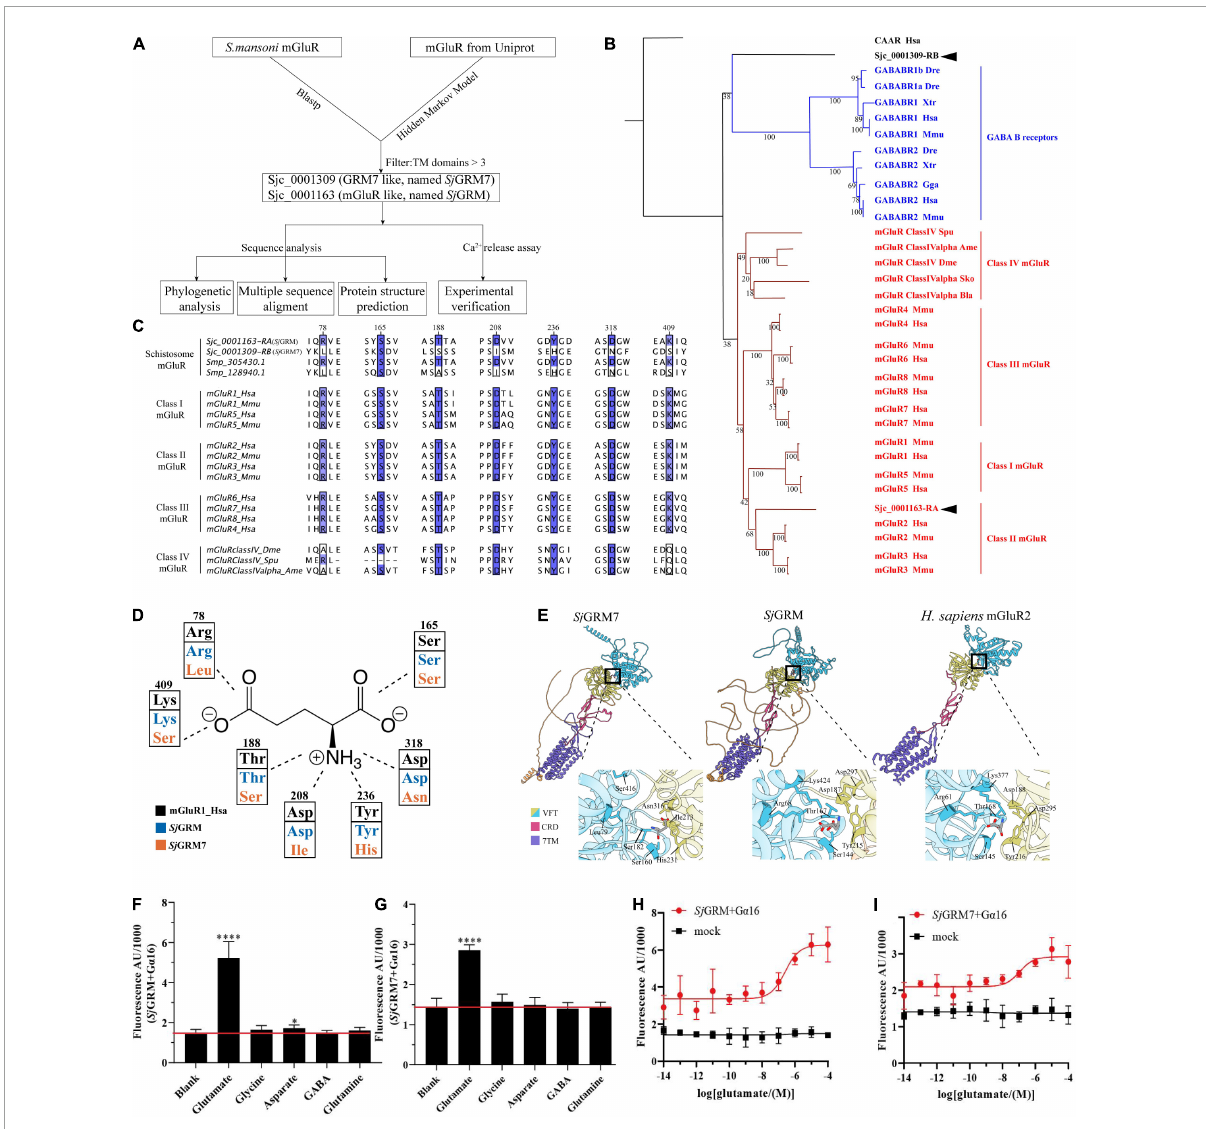
FIGURE1 Bioinformatic analysis reveals Sj GRM7 as a schistosome-specific mGluR. (A) A schematic for bioinformatics and functional analysis of S. japonicum mGluR. (B) mGluR maximum-likelihood tree. mGluRs and GABAB receptors (GABABR) are indicated by the branches and text colors. The text on the right shows further classification. Two S. japonicum mGluRs are highlighted in black. The species used in this analysis are implicated using a three-letter species code, except for S. japonicum (Sjc), S. mansoni (Smp), and Schmidtea mediterranea (SMESG). Phylogenetic reconstruction was performed using the maximum-likelihood method with the WAG + I + G + F model and an ultrafast bootstrap of 1,000 iterations. Bootstrap values are shown at the tree nodes, and protein names are shown at the end of each branch. The human calcium-sensing receptor was used as an outgroup. The scale bar denotes the number of amino acid substitutions per site. (C) Multiple protein alignments of mGluR ligand-binding residues. Representative sequences were chosen for each class with labels on the left. Key residues are colored according to percentage identity. The residue numbers indicated at the top correspond to those in human mGluR1. (D) Schematic depiction of mGluR’s key residues involved in ligand binding. Human mGluR key residues and those of S. japonicum are shown for comparison. As shown in panel (C) , the residue and its number corresponded to multiple protein alignments. Residues are colored based on proteins, as shown in the legend. The dashed line indicates the part of the glutamate the residue that interacts with other residues. (E) Protein structure comparisons between the predicted two mGluRs of S. japonicum structures and human mGluRII crystal structures. Different classes corresponded to other protein domains, as shown in the legend. Orange structures are intra-cellular regions, but most have low confidence (pLDDT < 50). Dashed lines in human mGluR2 denote disordered fragments. The binding pockets are shown by black boxes and are zoomed at the bottom right of each structure. Key residues involved in ligand binding are depicted in close-up views using the residue number and three-letter code. (F) Sj GRM-expressing HEK293 cells were treated with various amino acid transmitters ( L -glutamate, glutamine, GABA, glycine, and aspartate) at 10 - 4 M or vehicle (blank). (G) Sj GRM7-expressing HEK293 cells were treated with various amino acid transmitters ( L -glutamate, glutamine, GABA, glycine, and aspartate) at 10 - 4 M or vehicle (blank). (H) Sj GRM-expressing HEK293 cells were treated with different concentrations of L -glutamate, and the vector (blank) was plotted in a dose-dependent manner. (I) Sj GRM7-expressing HEK293 cells were treated with different concentrations of L -glutamate, and the vector (blank) was plotted in a dose-dependent manner. mGluR and GRM, metabotropic glutamate receptor; HEK293, human embryonic kidney 293T cells, GABA, γ -aminobutyric acid. * P < 0.05, **** P <